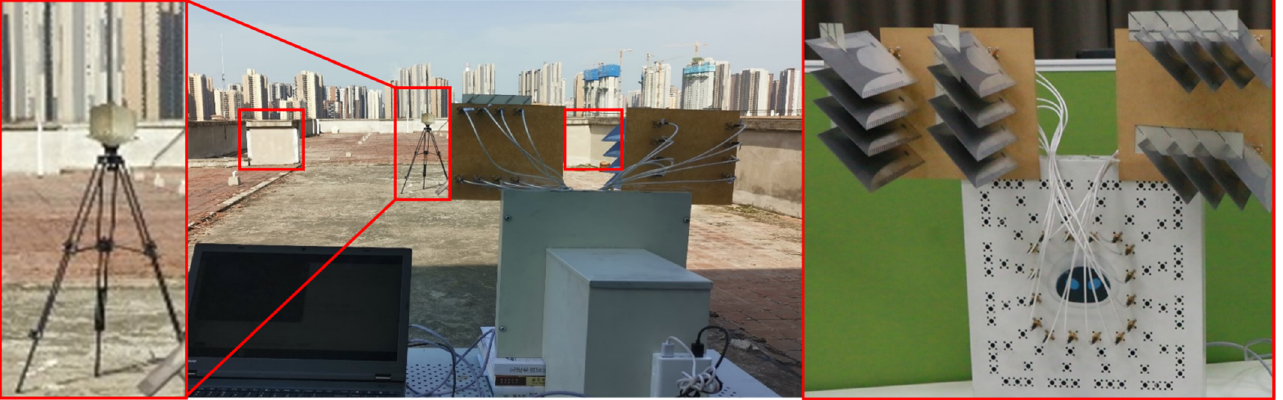
Figure 27. SDR-MIMO radar experiment setup. The left image shows the trihedral CR and the right image shows the front side of the radar system and the array geometry.